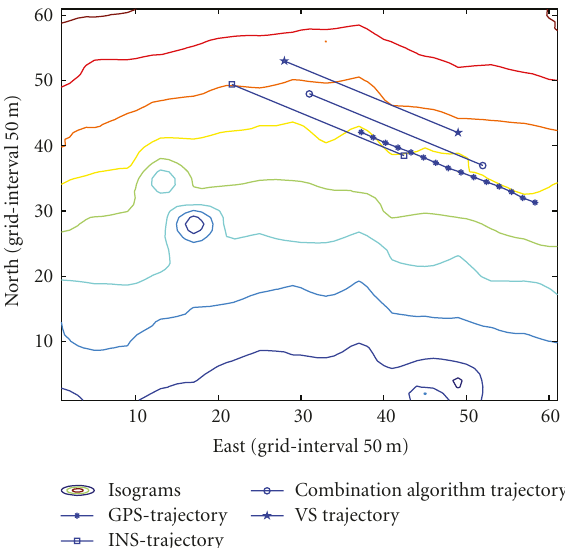
Figure 9: Daily variation corresponding to the real-measurement sequence.